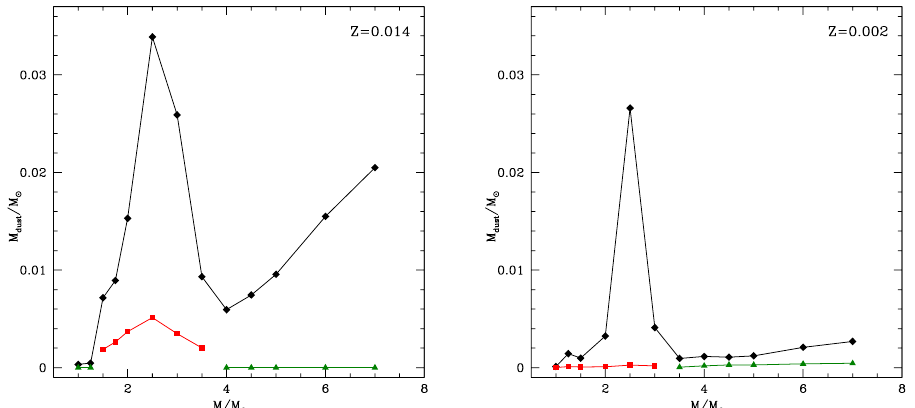
Figure 6. The total mass of stars with the initial mass reported on the abscissa is indicated with black diamonds for the metallicities Z = 0.014 ( Left ) and Z = 2 × 10 − 3 ( Right ). Red squares and green triangles indicate the contribution due to SiC and alumina dust,